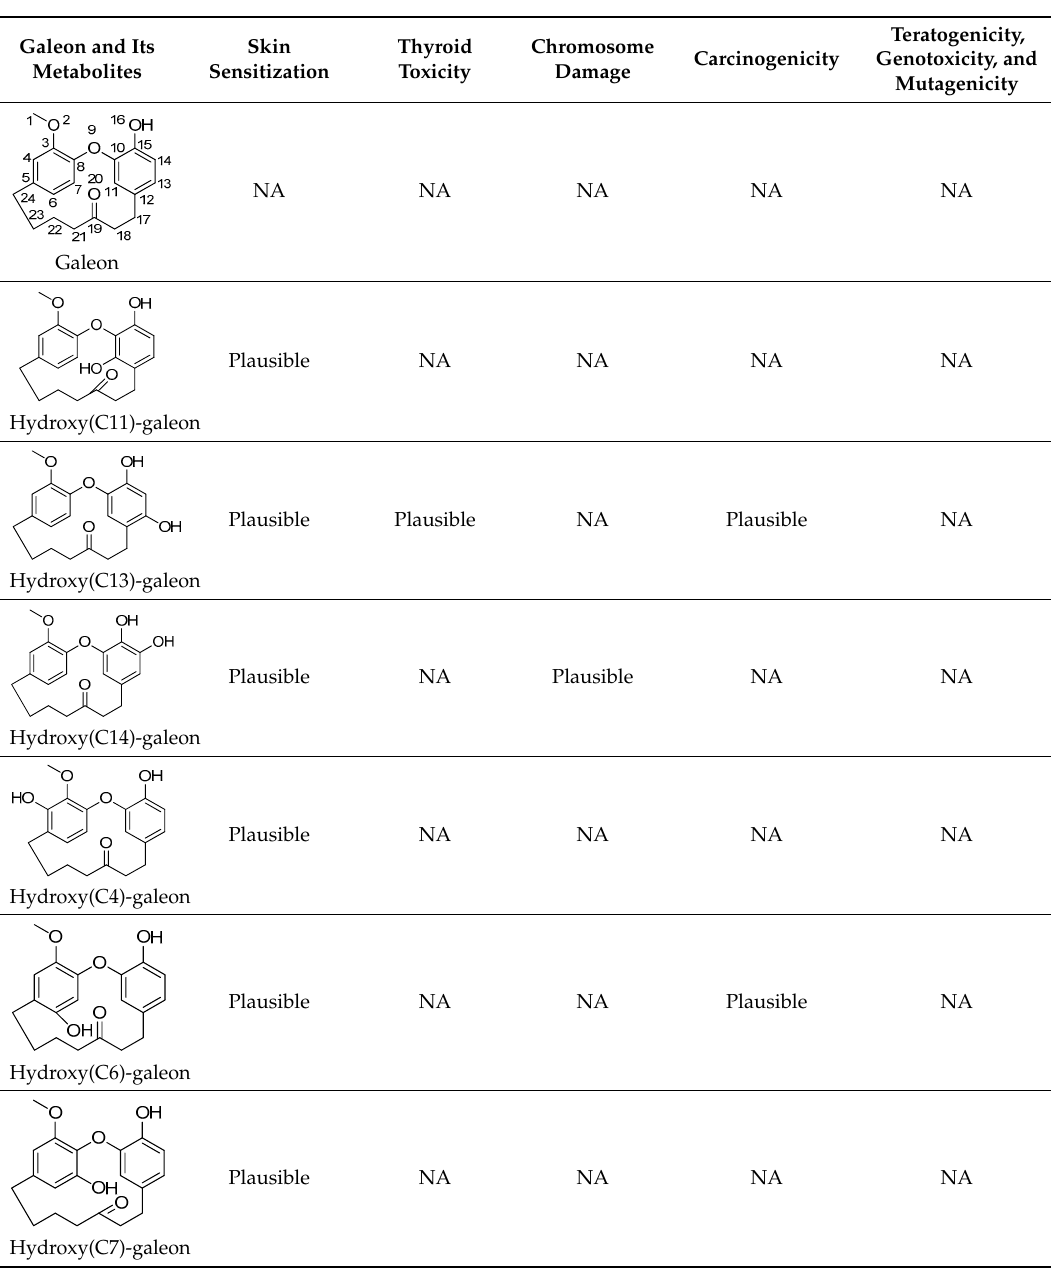
Table 1. Qualitative toxicity prediction of galeon and its metabolites by Deductive Estimation of Risk from Existing Knowledge (DEREK) software analysis.